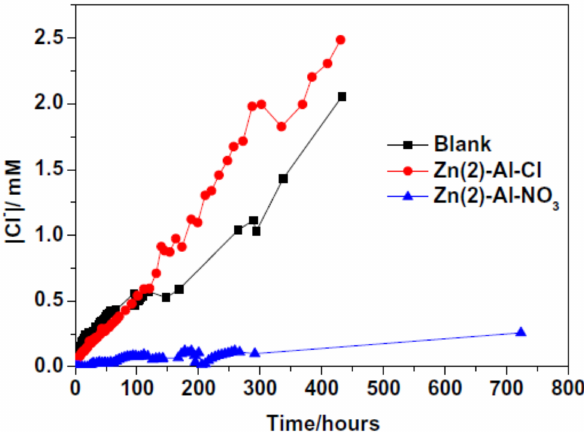
Figure 17. Permeability measurements of Cl − through the coating as a function of time. Reproduced with permission from Tedim et al., Corrosion Science; published by Elsevier, 2012